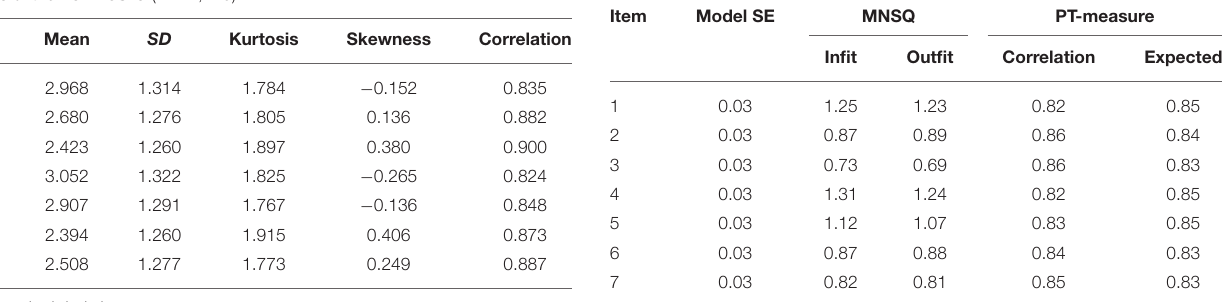
TABLE 1 | Means, SD s, kurtosis, skewness, and corrected item–total correlation results of the FCV-19S-C ( n = 2,445).